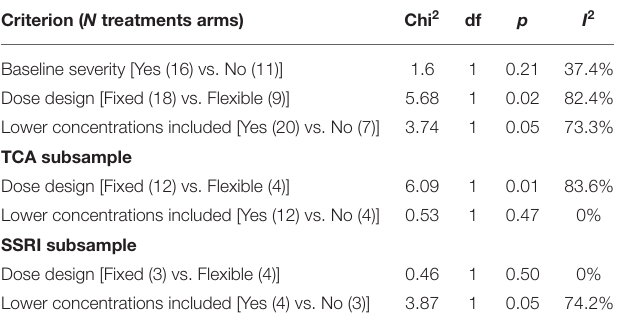
TABLE 4 | Subgroup analyses of potential